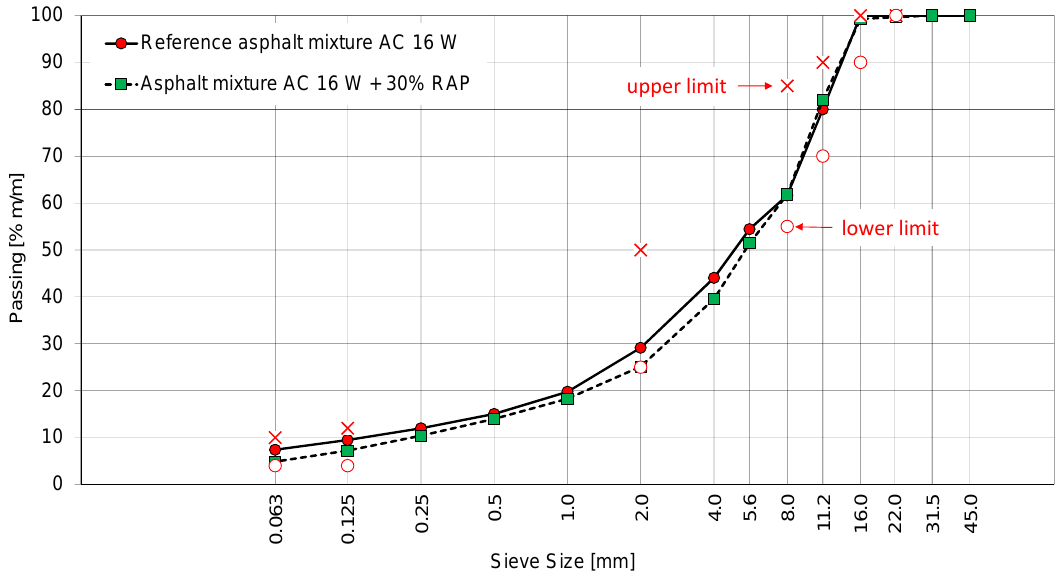
Figure 1. Gradation of asphalt mixture AC 16 containing 30% reclaimed asphalt pavement (RAP); the presented limit points are according to Polish specifications WT-2: 2014.